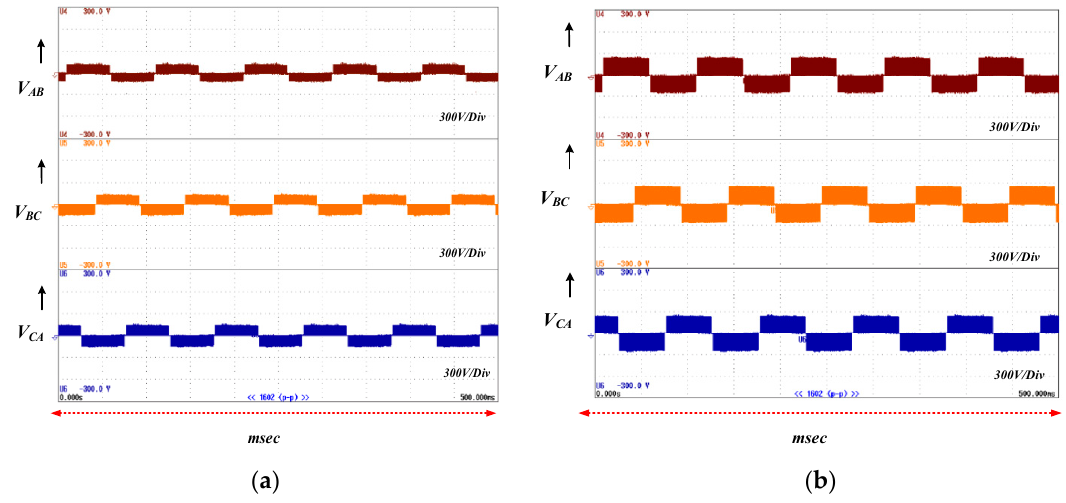
Figure 12. Excremental results MCRSVPWM: ( a ) Line voltage for M a = 0.6, ( b ) Line voltage (V AB ) for M a = 0.9.